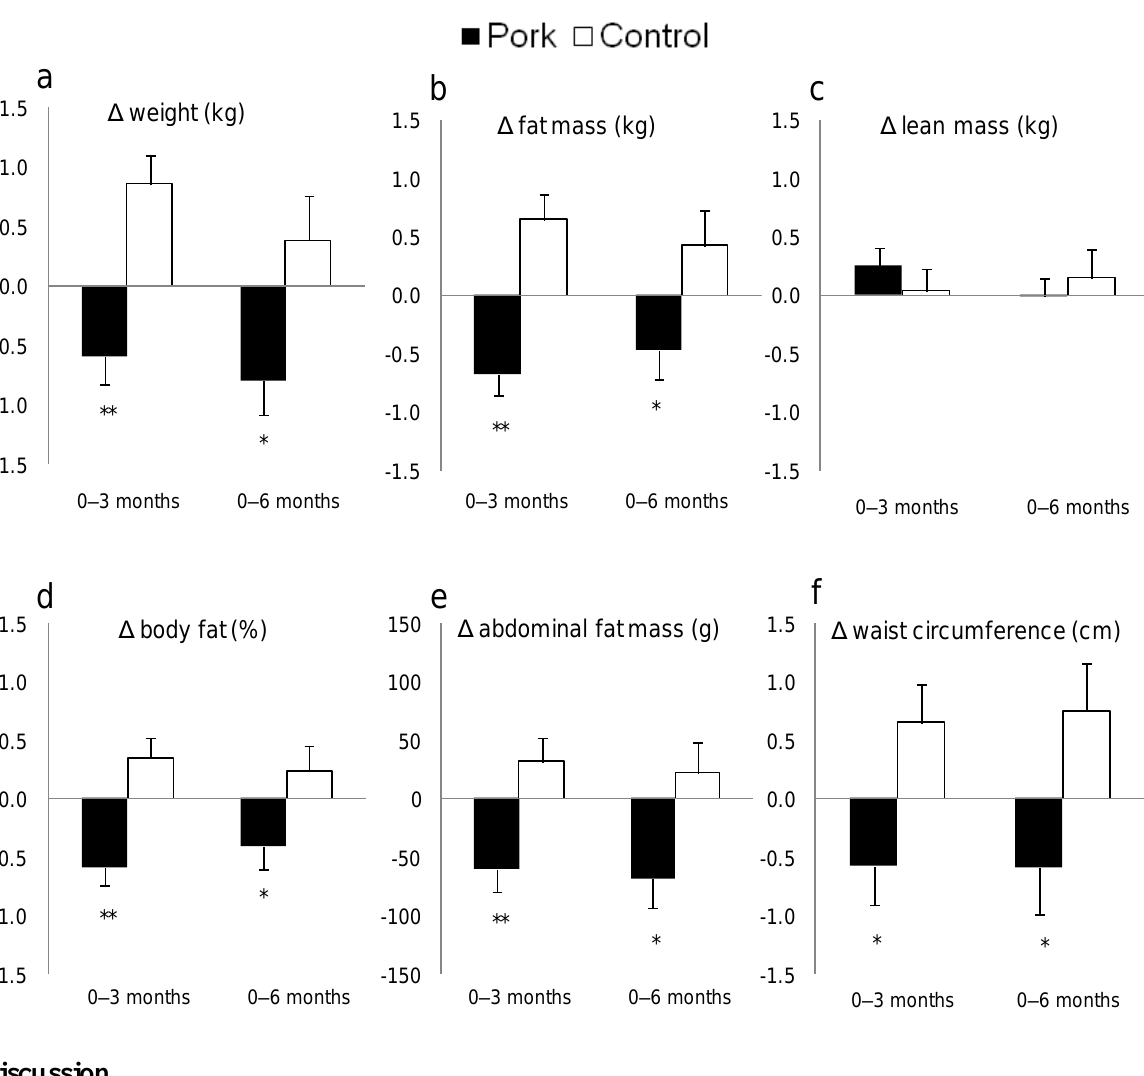
Figure 3. Change in ( a ) weight (kg); ( b ) fat mass (kg); ( c ) lean mass (kg); ( d ) body fat (%); ( e ) abdominal fat mass (g); and ( f ) waist circumference (cm) for pork and control groups 3 and 6 months. Values are means ± SEM. * Significantly different from change